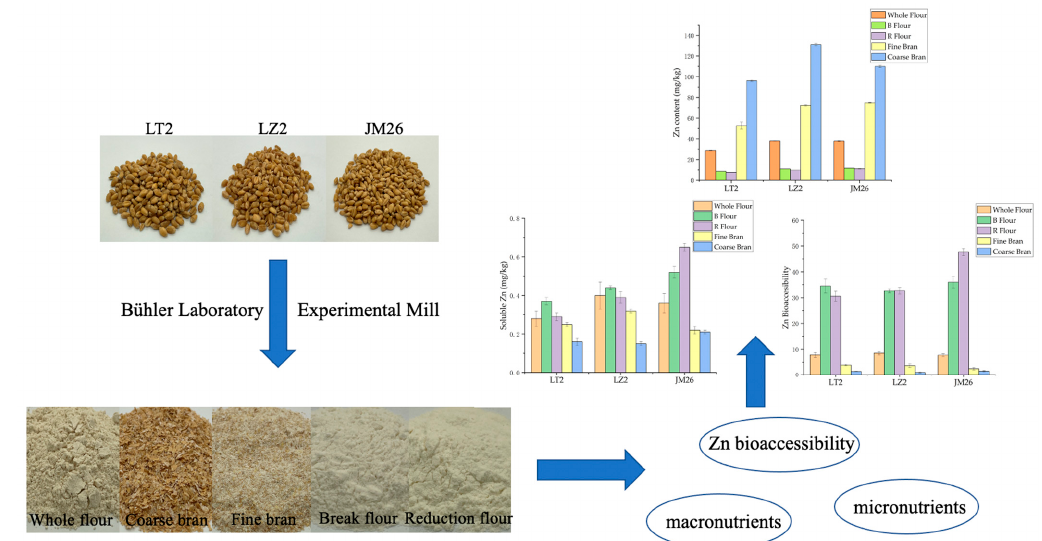
Figure A1. The conceptual figure of this study.